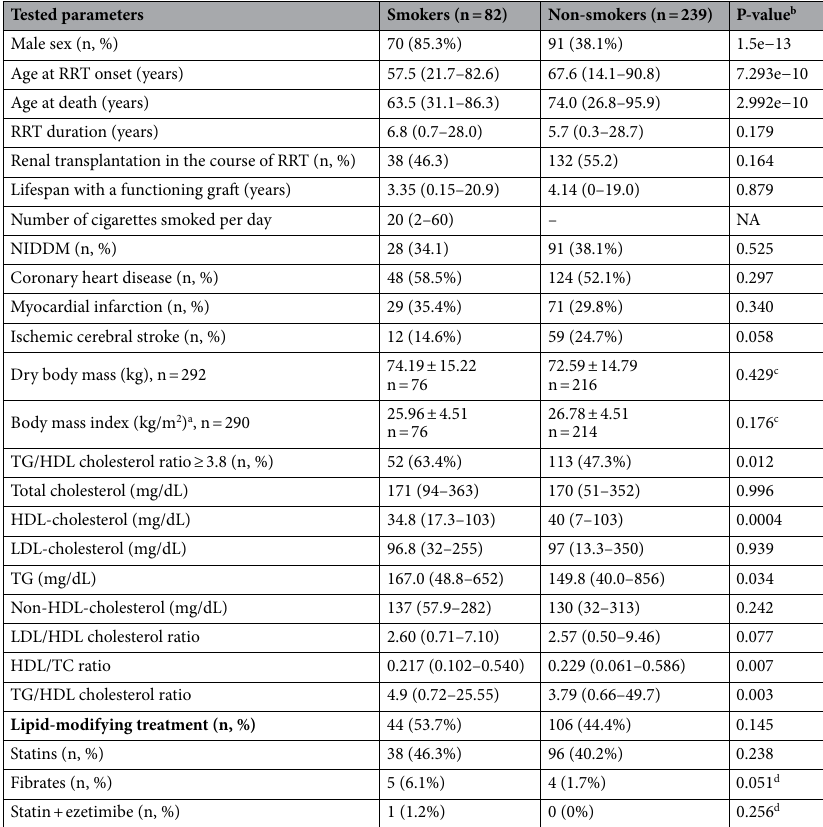
Table 1. Characteristics of HD patients who died from cardiovascular reasons concerning cigarette smoking status. a Dry body mass was not calculated in 2 patients due to amputation of the leg(s); b Mann–Whitney U test for quantitative variables and Pearson’s Chi-squared test for qualitative variables; c Student’s T-test; d Fisher’s Exact Test. HD hemodialysis, HDL high-density lipoprotein, LDL low-density lipoprotein, NA not applicable, NIDDM non-insulin-dependent diabetes mellitus, RRT renal replacement therapy, TG triglycerides. Conversion to SI units: to change cholesterol to mmol/L, divide by 38.6; triglycerides to mmol/L, by